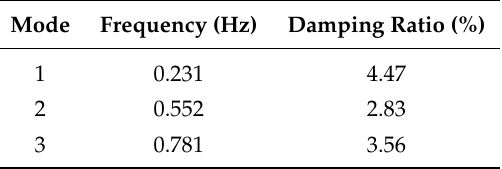
Table 1. Oscillation modes of the test